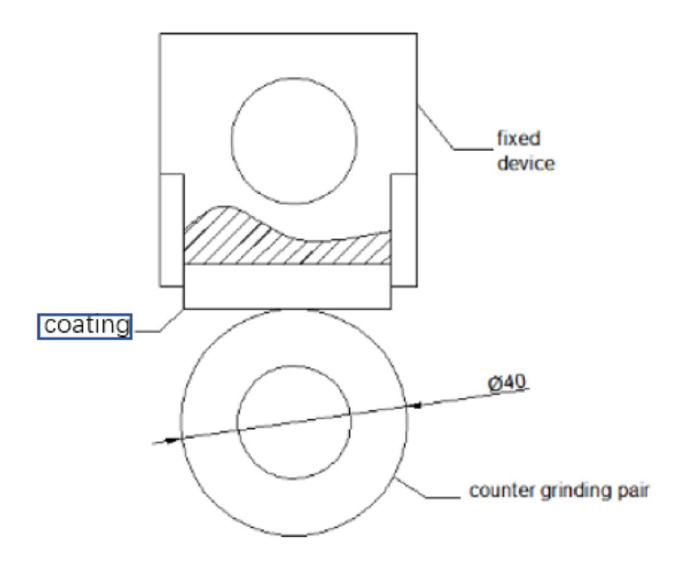
Figure 2. Schematic diagram of wear experiment.